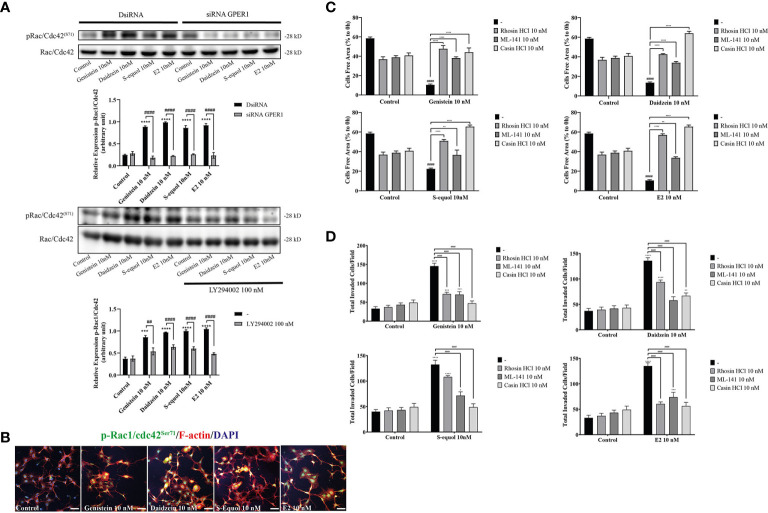
Effects of isoflavones on phosphorylation of RhoGTPase and their involvement on cell migration and F-actin formation. (A) Western blot analysis for pRac1/Cdc42 and Rac1/Cdc42 levels after 30 min exposure of isoflavones or E2 in the astrocytes that have been transfected with DsiRNA or short interfering RNA (siRNA) G-protein-coupled estrogen receptor (GPER), or co-exposure with LY194002. Representative blots are shown in the upper panel, whereas quantitative analysis results are shown in the lower panel. (B) Representative photomicrographs showing immunocytochemistry results for pRac1/Cdc42 with F-actin and DAPI staining to examine the effects of isoflavones or E2 in astrocytes. Astrocytes were exposed to isoflavones for 60 min after serum starvation for 6 h. (C) Quantitative analysis of the effect of rhosin HCl (RhoA inhibitor), ML-141 (Rac1/Cdc42 inhibitor), and casin HCl (Cdc42 inhibitor) on isoflavone-accelerated cell migration measured by wound healing assay. (D) Quantitative analysis of the effect of rhosin HCl (RhoA inhibitor), ML-141 (Rac1/Cdc42 inhibitor), and casin HCl (Cdc42 inhibitor) on isoflavone-accelerated cell migration measured by cell invasion assay. Bars represent 50 μm. Data are expressed as mean ± SEM and are representative of at least three independent experiments. ****p < 0.0001, ***p < 0.001, **p < 0.01, *p < 0.05, indicates statistical significance measured using Bonferroni’s test compared with control (-). ####p < 0.0001, ###
p < 0.001, ##
p < 0.01, indicates statistical significance measured using Bonferroni’s.